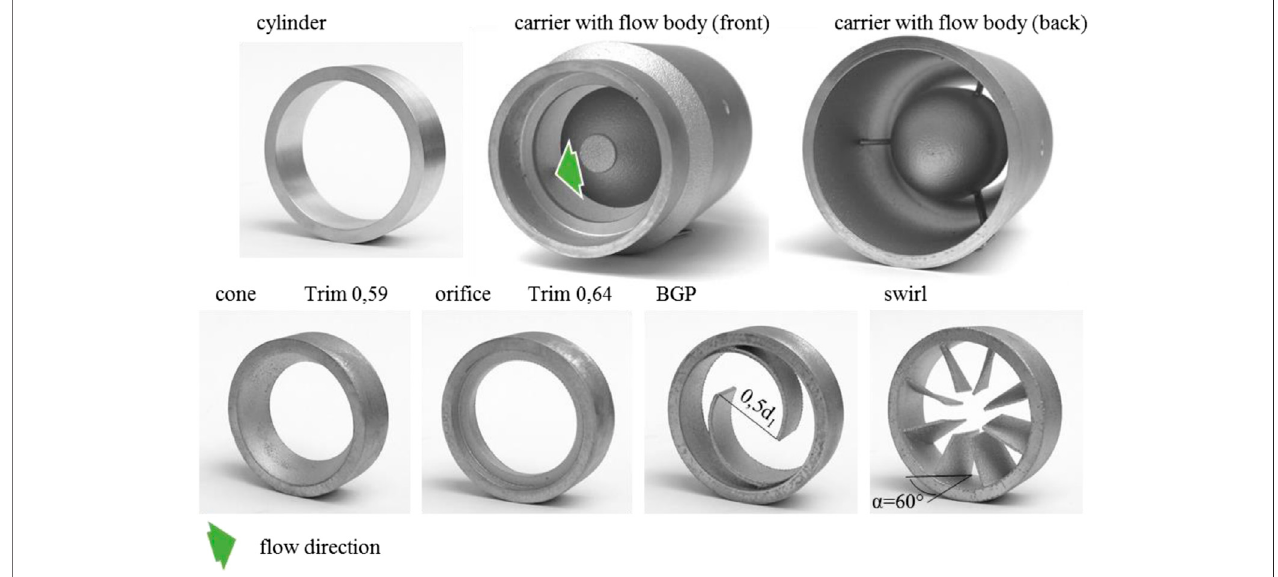
FIGURE 10 | Inserts for producing a trim reduction (cone, ori fi ce) and to produce a swirl (swirl, BGP); insert carrier (top right and middle) to position the inserts in front of the compressor